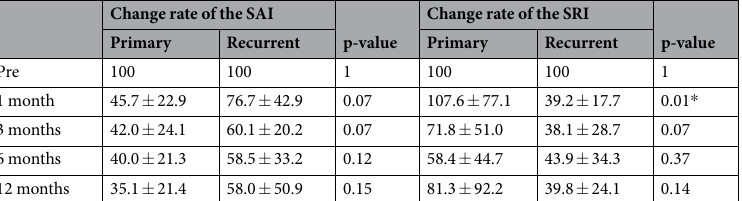
Table 4. Change rate of the surface asymmetry index (SAI) and surface regularity index (SRI) after surgery of grade 3 pterygium. * p < 0.05. All values are presented as mean ± standard deviation.